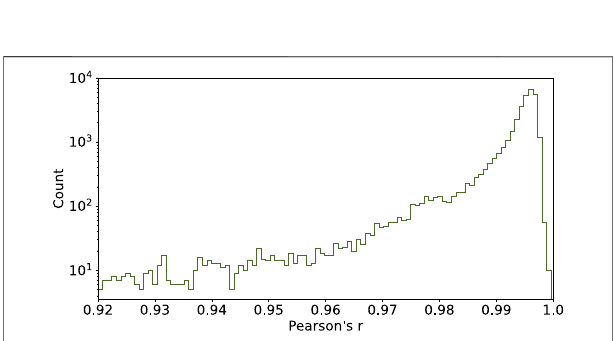
FIGURE 5 | PCC value distribution for 33539 images since AST3-3 starts observation in 60-s exposure modes.